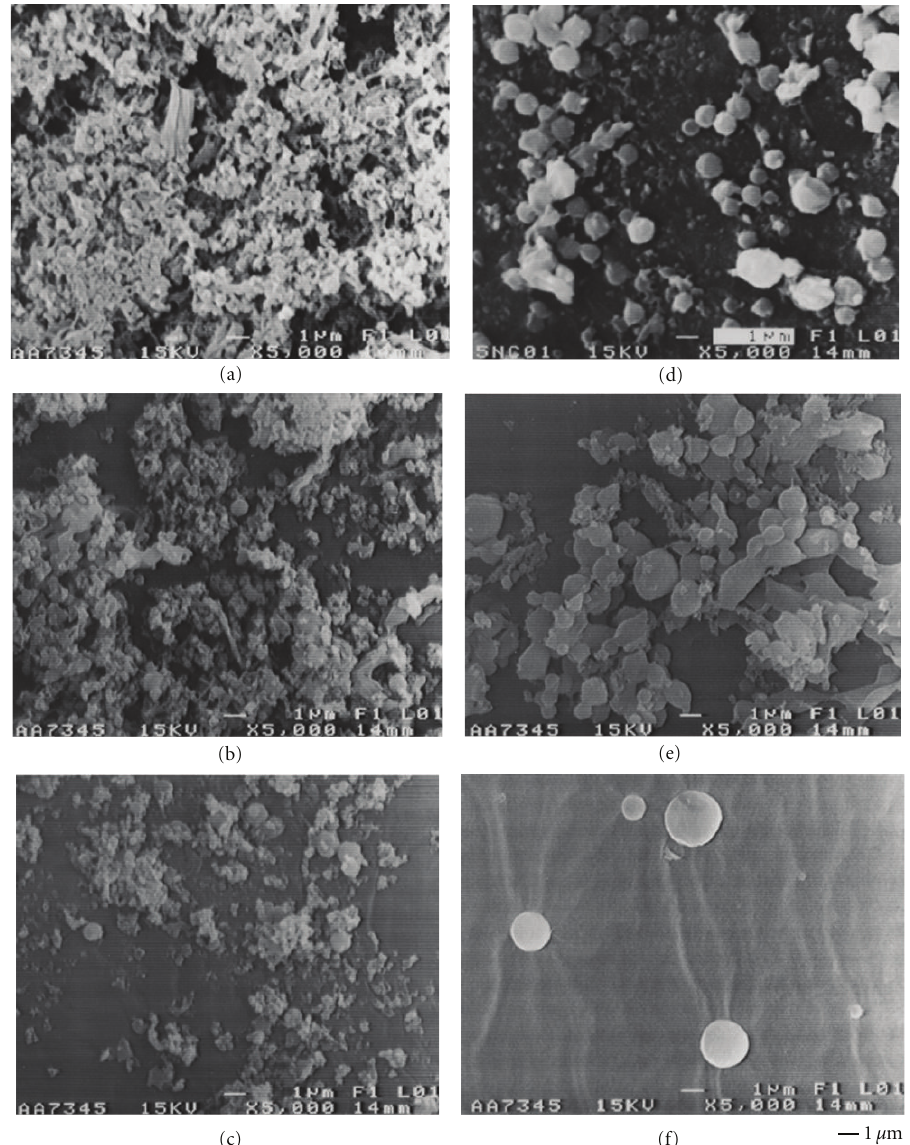
Figure 6: SEM images of the polymer particles obtained at the cloud point pressure +200 (a), ± 0 (b), –100 (c), − 300 (d), − 900 (e), and − 1500 psi